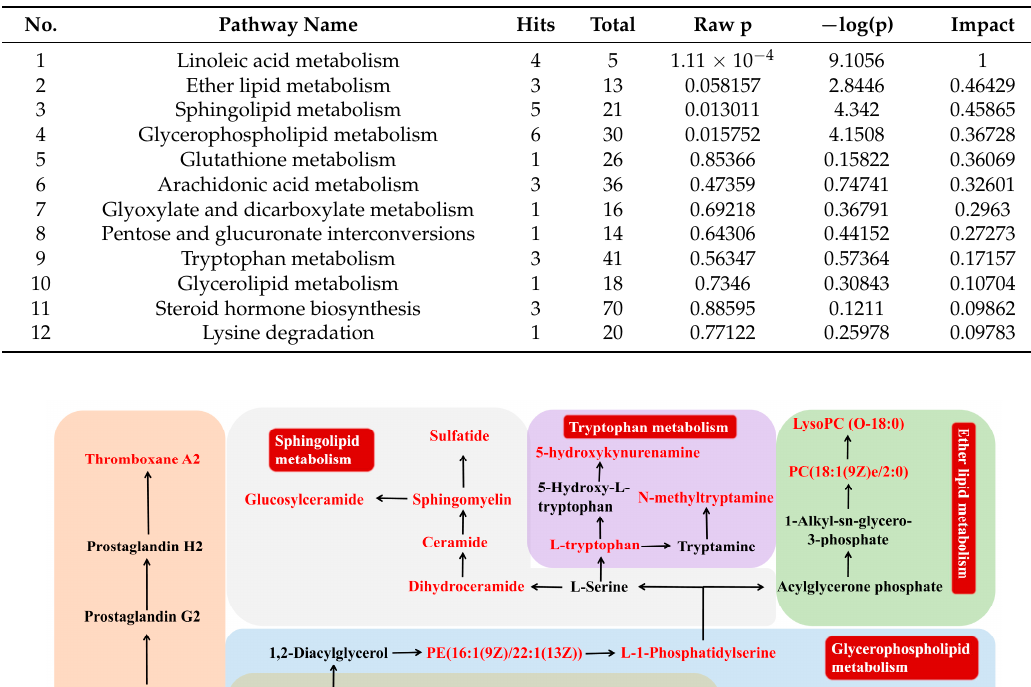
Table 3. Pathway analysis result with MetaboAnalyst 4.0.